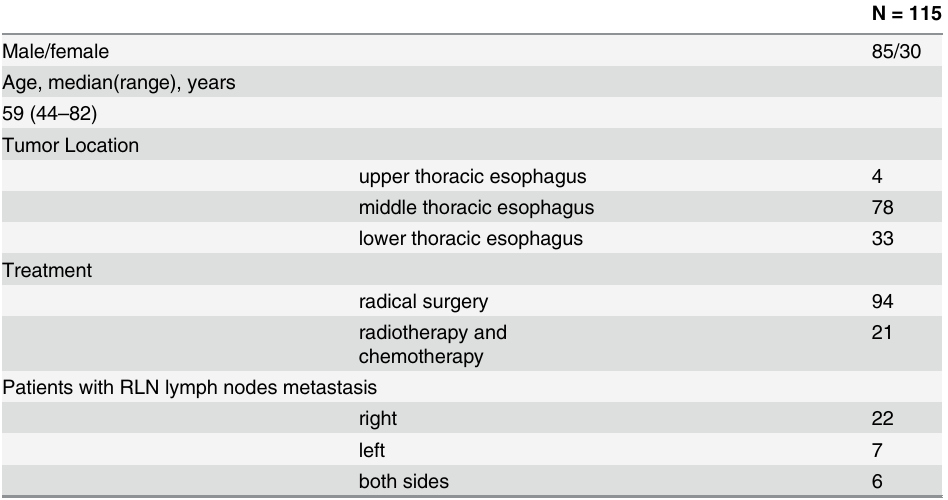
Table 1. General information about of